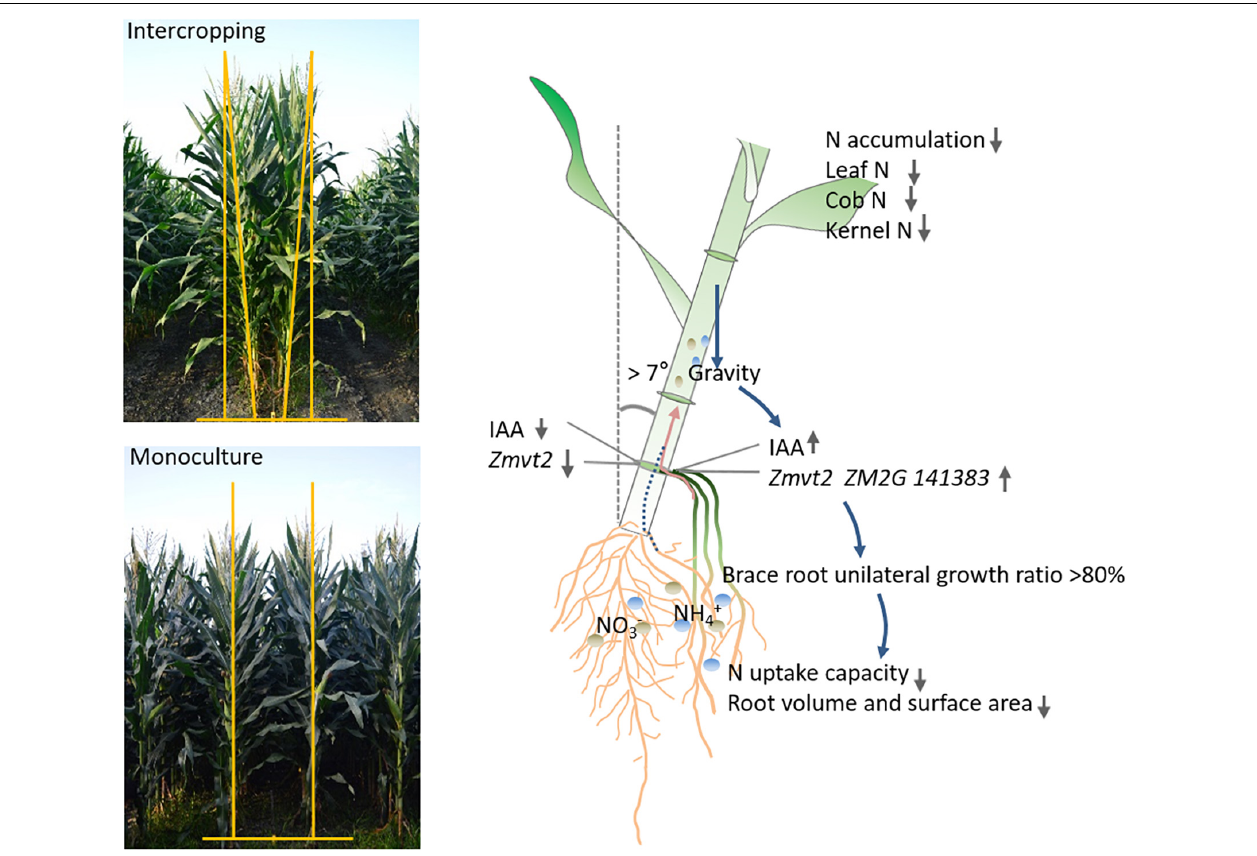
FIGURE 10 | An integrated model of N uptake of intercropped maize response to gravity. The plants tilted toward the wide row, gravity-induced the expression, and upregulation of auxin biosynthesis genes ( Zmvt2 and ZM2G141383 ), IAA accumulation. In more than 80% of plants, the brace root grown in a wide row was absent on the other side. Subsequently, the root volume and surface area were reduced, resulting in decreased N uptake capacity. The leaf, cob, and grain N accumulation were also